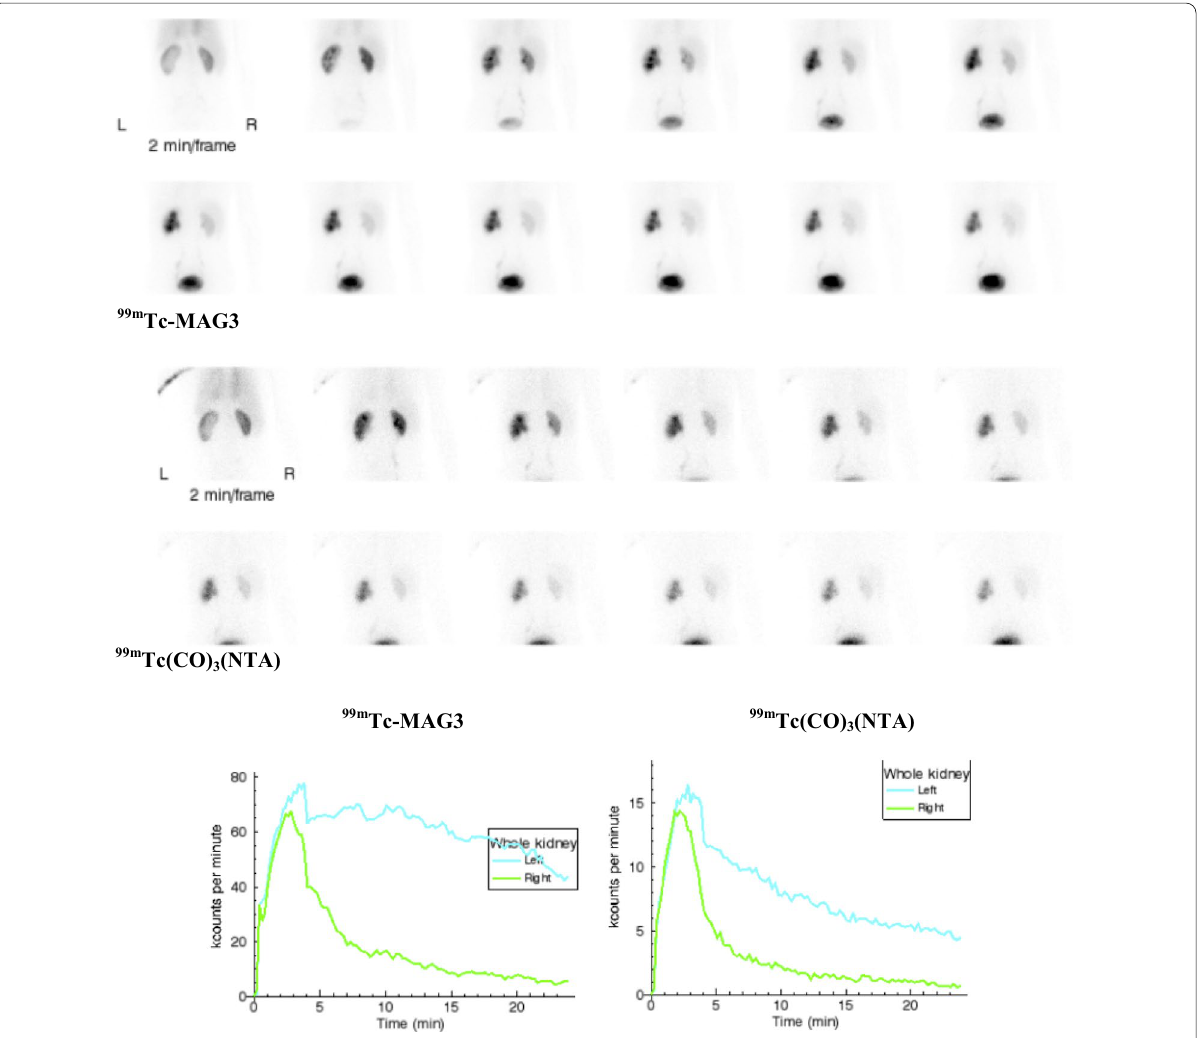
Fig. 4 Subject 13: Two minute sequential images following the administration of [ 99m Tc]Tc-MAG3 (320 MBq) and [ 99m Tc]Tc(CO) 3 (NTA) (54 MBq) with the corresponding renogram curves. The relative uptake of the left kidney was 50% for both tracers. The T1/2 of the left kidney for MAG3 was > 50 min and the 20 min/maximum count ratio was 0.79 compared to a T1/2 of 7 min and 20 min/max count ratio of 0.34 for NTA. The images, renogram curve, prolonged T1/2 and elevated 20 min/max ratio of the MAG3 study might be interpreted as indeterminate for obstruction or representing an obstructed left kidney. In contrast, the combination of a normal T1/2, equal uptake by the two kidneys and a normal 20 min/max ratio for NTA study excludes left kidney